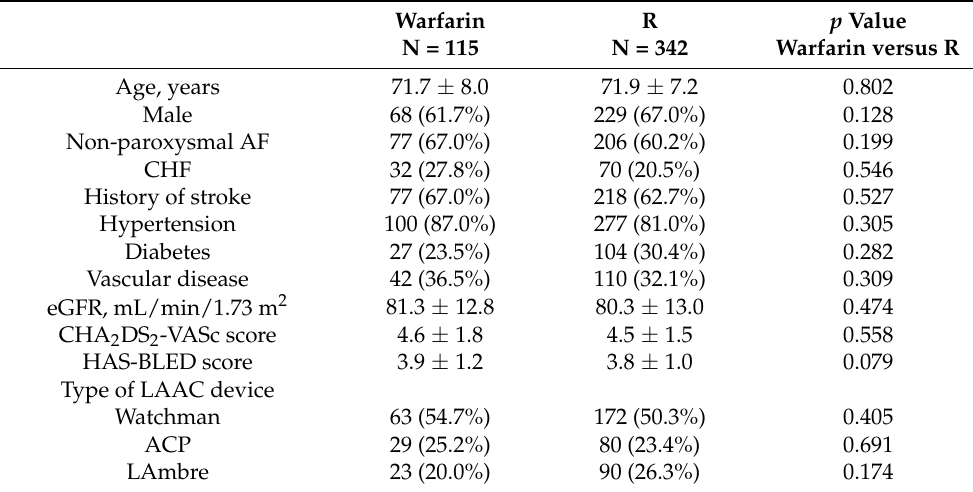
Table 2. Baseline patient characteristics stratified by warfarin, reduced-dose, and half-dose rivaroxaban.